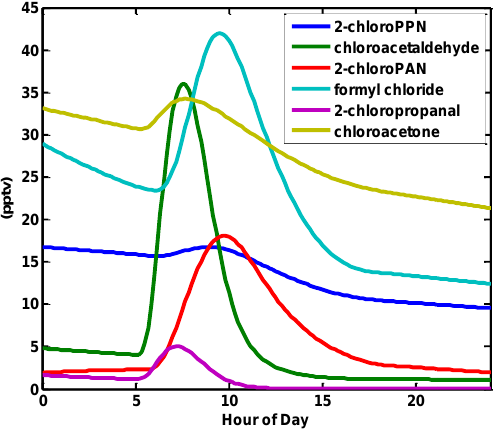
Fig. 3. Mixing ratios of various chlorinated species tracked in the model for the with-ClNO 2 model case.